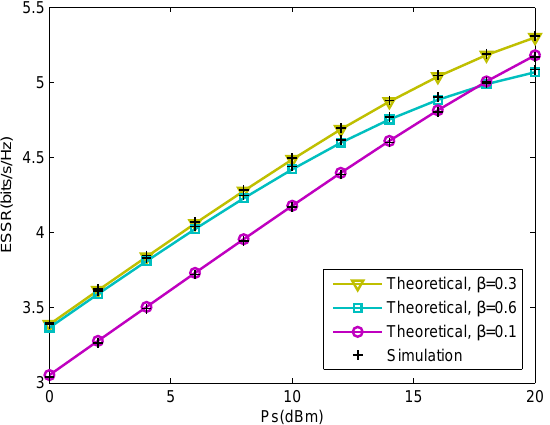
Figure 3. ESSR versus the whole transmit power P s